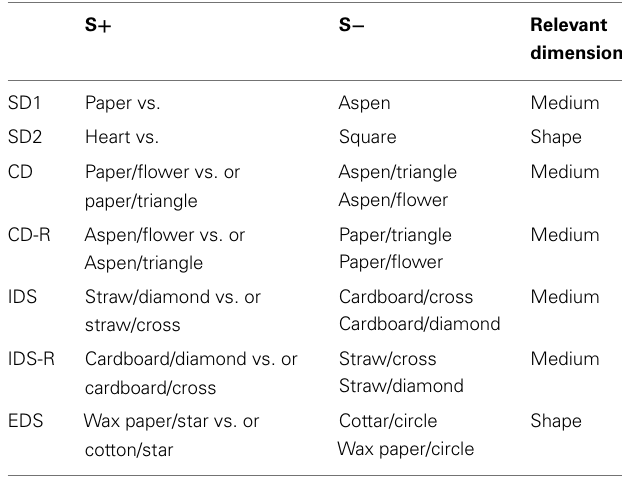
Table 1 | Relevant dimension and positive discriminators used for each stage of theAST